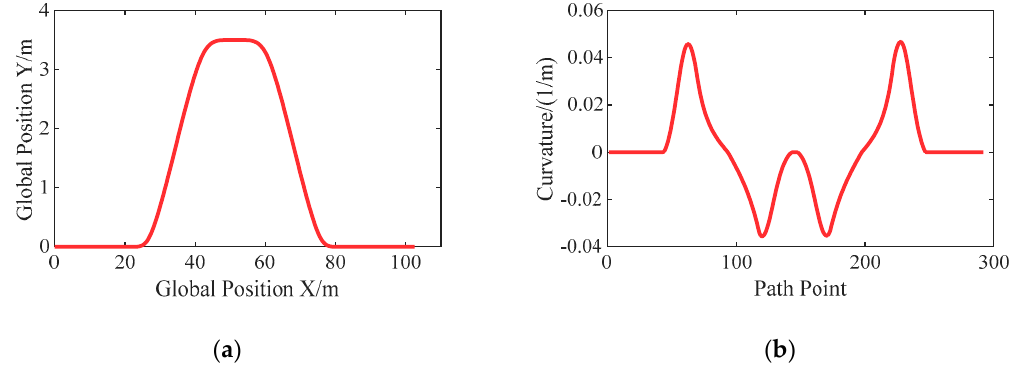
Figure 8. Setting of the double lane change test case: ( a ) Path; ( b ) Curvature.